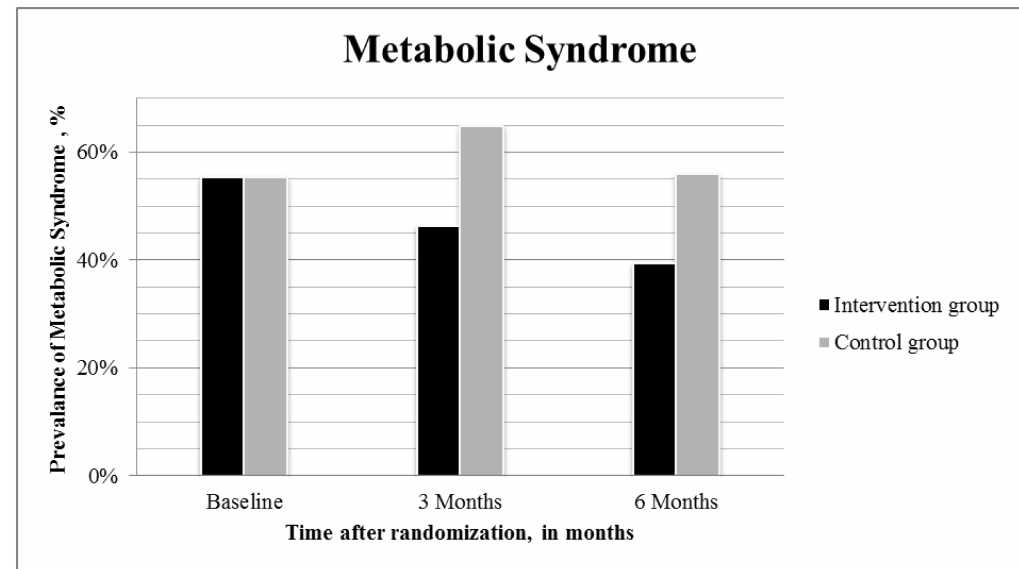
Fig 2. Prevalence of metabolic syndrome, at baseline, three and six months, by randomization group.